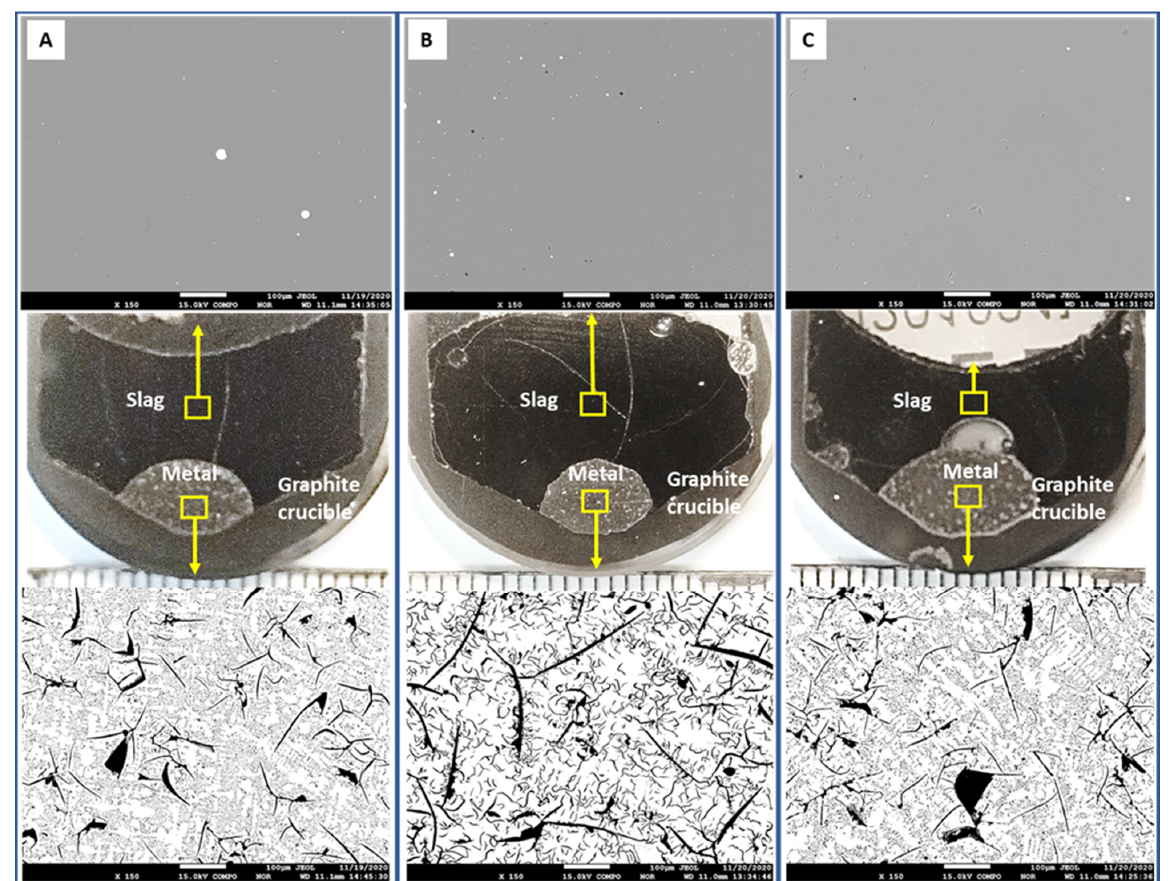
Figure 6. Differences between the analyzed (EPMA) and calculated (ICP-OES) slag compositions. Experiments using concentrates R1, R2/u, and R3 with ( A ) 7% CaF 2 , ( B ) 5% CaO, and ( C ) 7% CaF 2 + 5% CaO.